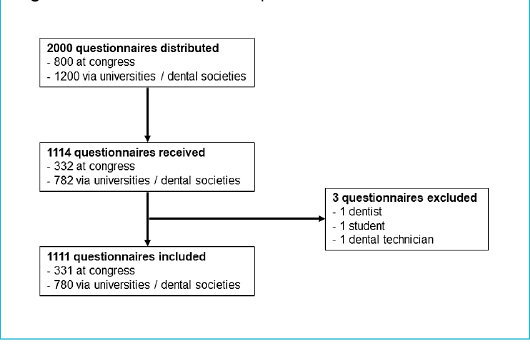
Figure 1: Flowchart of included questionnaires.